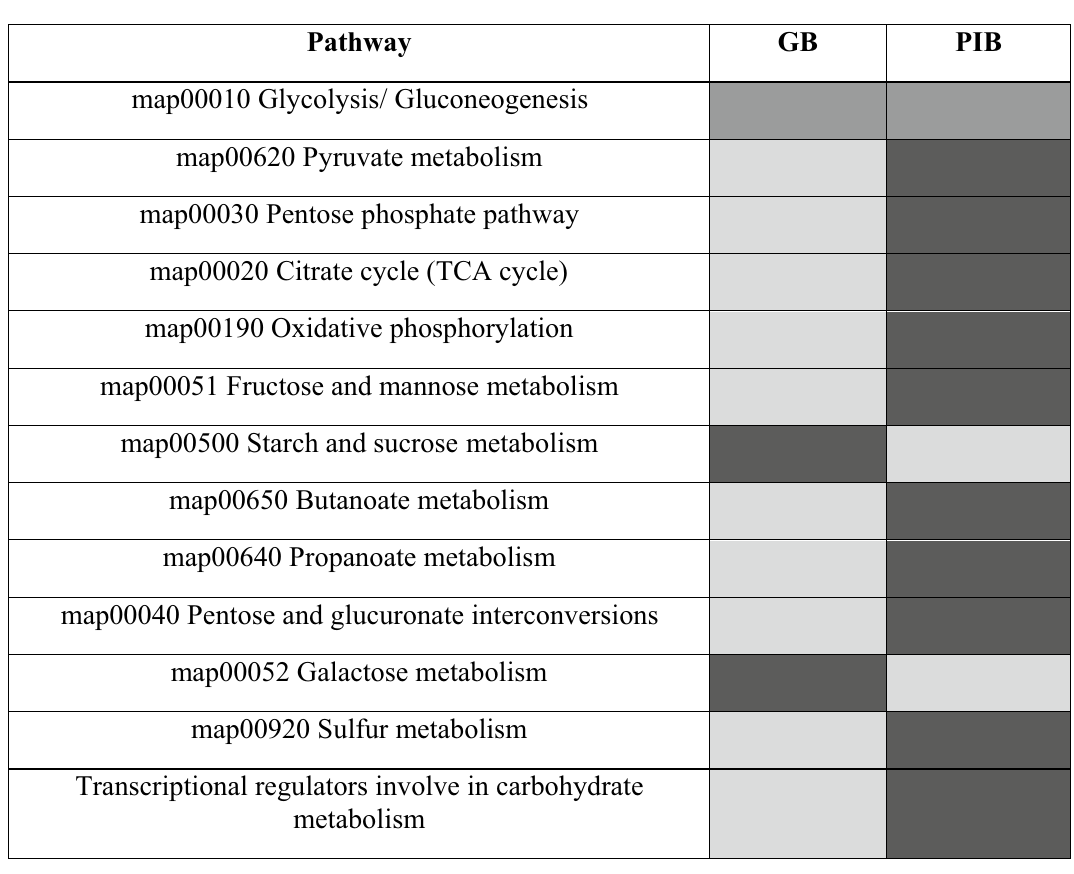
Table 3. Pathways related to carbohydrate metabolism and transport and energy production and conversion in the GB and PIB groups. Light grey represents decreasing, dark grey represents increasing, and medium grey represents approximately equal functions.